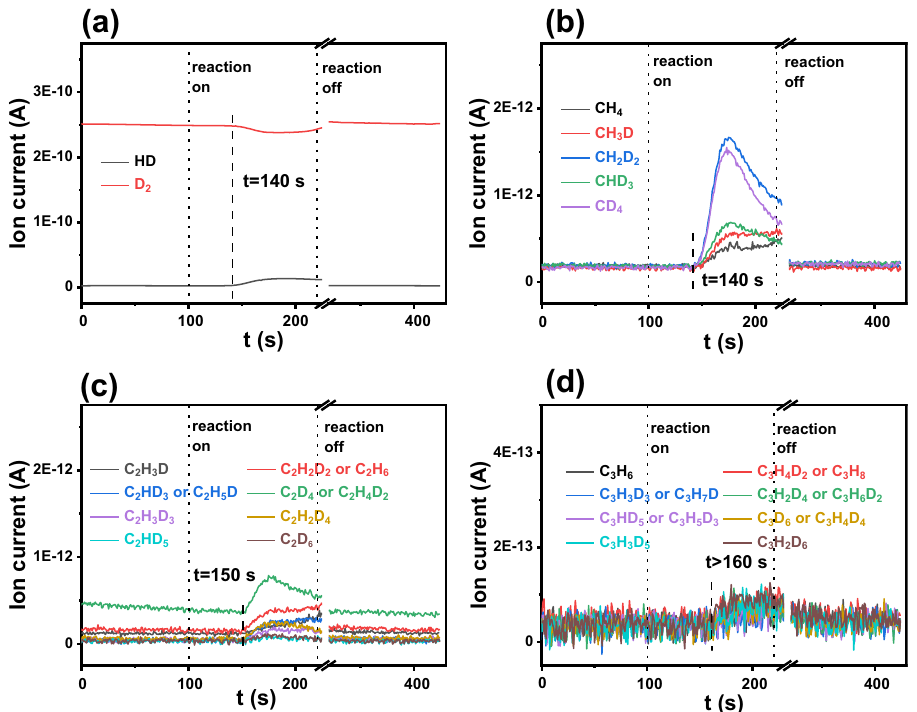
Fig. 3 Time-evolved ( t ) gas products evolution during D 2 isotope labeling PS hydrogenolysis reaction. Mass spectra for ( a ) H 2 (HD), ( b ) C 1 , ( c ) C 2 , and ( d ) C 3 species. The reaction was switched on at 100 s, and switched off after 120 s. signals are detected starting from about 40 s after the reaction is dependence. Methane and deuterium-exchanged methane pro- switched on (Fig. 3a). Considering only PS contains hydrogen, the ducts begin to be detected simultaneously with HD generation generation of HD should be resultant of reaction between highly (Fig. 3b), with CH 2 D 2 and CD 4 being the major products. In active deuterium plasma species and PS, which generates comparison, there are about 10 more seconds of delay for C 2 hydrocarbon fragments and hydrogen species that would further products detection and about 20 more seconds of delay for C 3 products detection (Fig. 3c, d). These results suggest the forma- react with deuterium. Interestingly, the generation of various tion of gas products following an order of CH 4 > C 2 H 4 ≈ C 2 H 6 > hydrocarbon gas products exhibits a different reaction time NATURE COMMUNICATIONS| (2022) 13:885